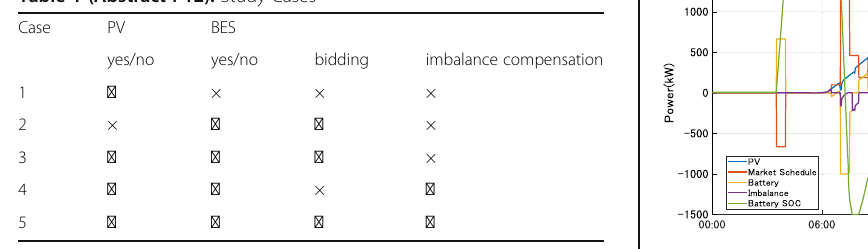
Fig 3 (Abstract P12). Dispatch control for BES at case